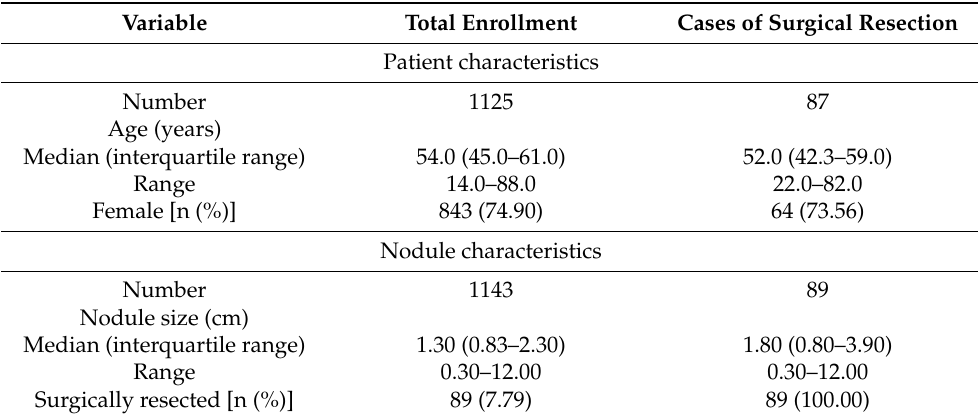
Table 1. Baseline characteristics of the study population and included thyroid nodules with nondiag- nostic or unsatisfactory cytopathological